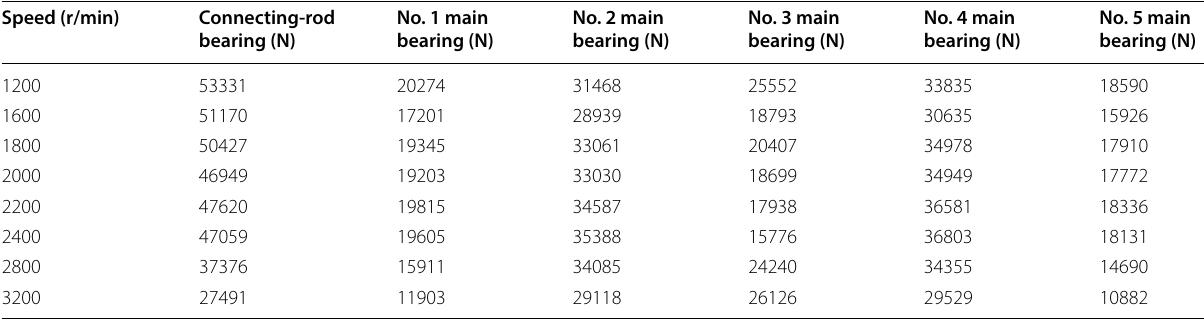
Table 2 Maximum loads of connecting‑rod bearing and all main bearings at full load and different speed Speed (r/min)